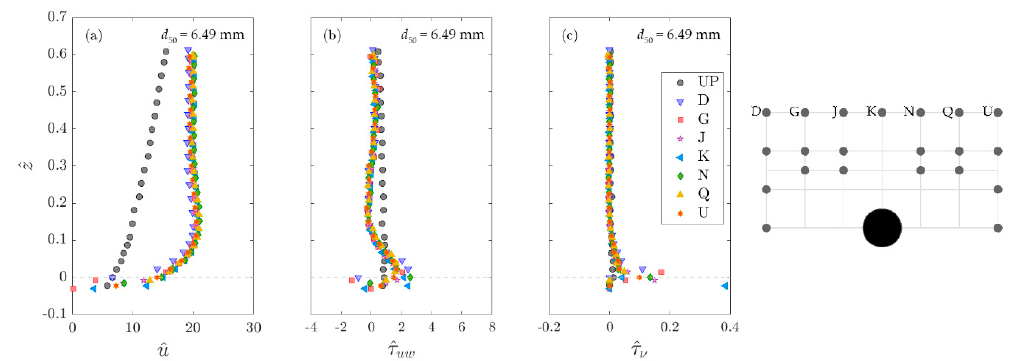
Figure 9. Vertical distributions of ( a ) dimensionless time-averaged velocity, ( b ) dimensionless Reynolds shear stress, and ( c ) dimensionless viscous shear stress at y = 0 in Run 2.